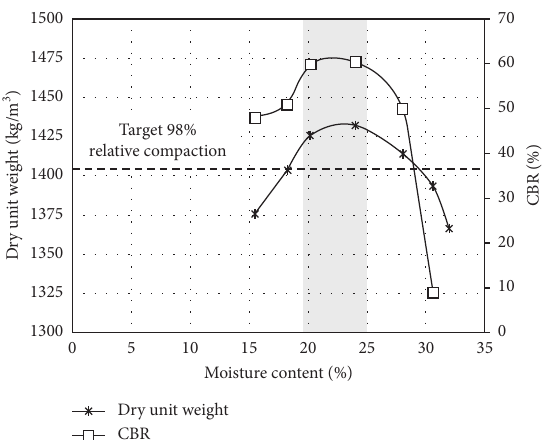
Figure 2: Standard Proctor and California bearing ratio results.